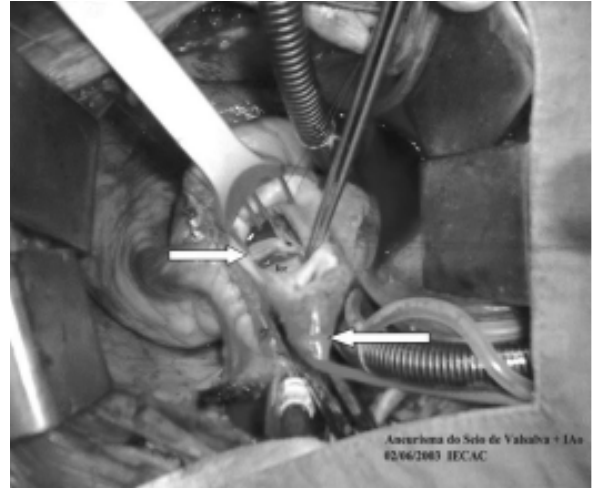
Fig. 2 - Ventrículo direito aberto, mostrando pseudo-aneurisma com colo, em torno de 2 cm (seta inferior esquerda). A seta superior direita mostra a veia cava inferior